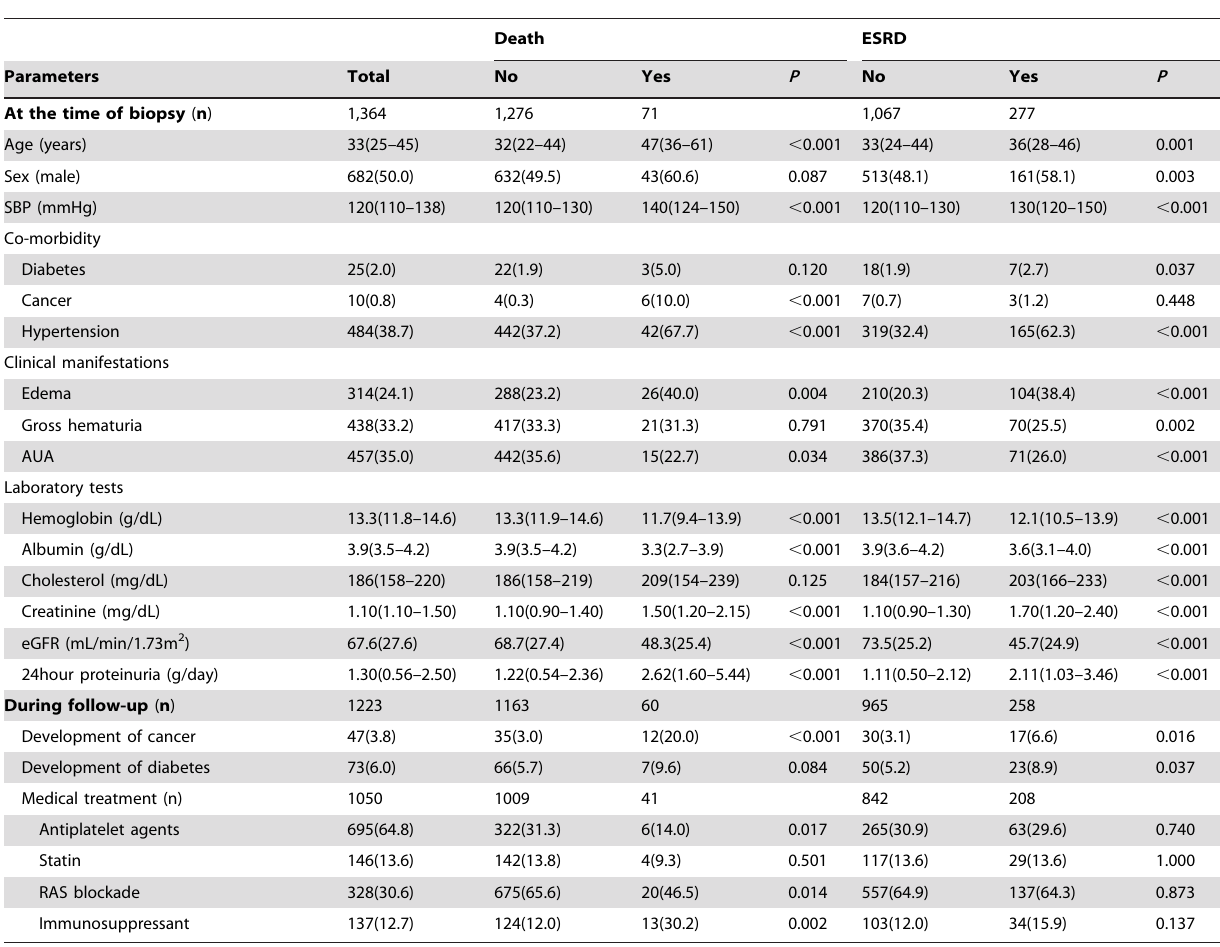
Table 1. Baseline demographic and clinical